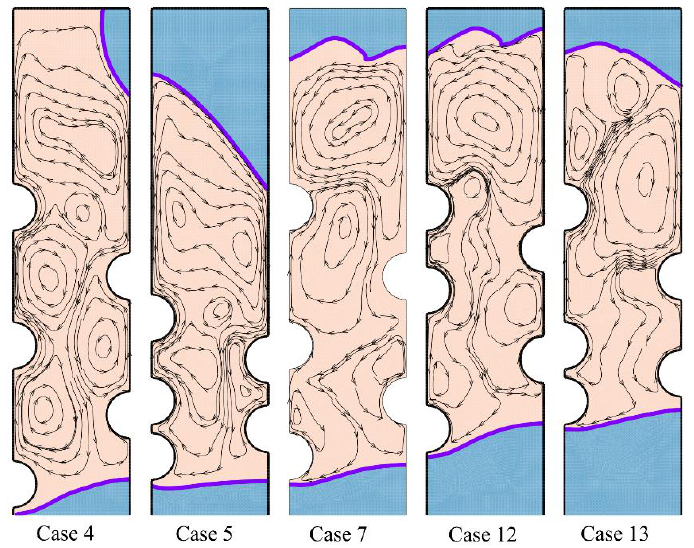
Figure 10. The streamlines and phase change interfaces for five different tubes ’ arrangement after three hours of charging.